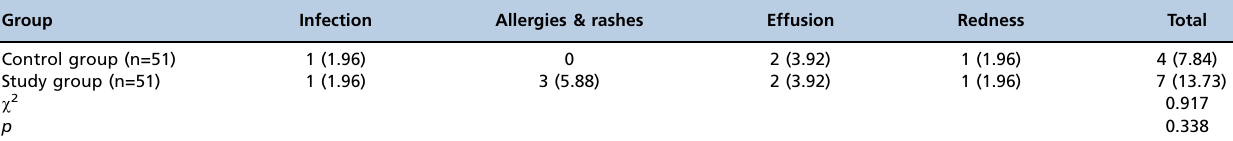
Table 4 - Comparison of postoperative complications between the two groups (n